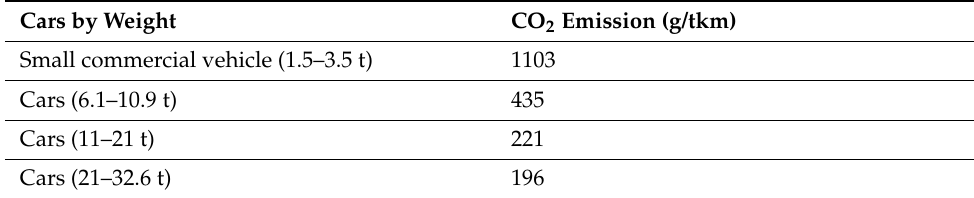
Table 1. CO 2 emissions of different types of freight vehicles [22]. Cars by